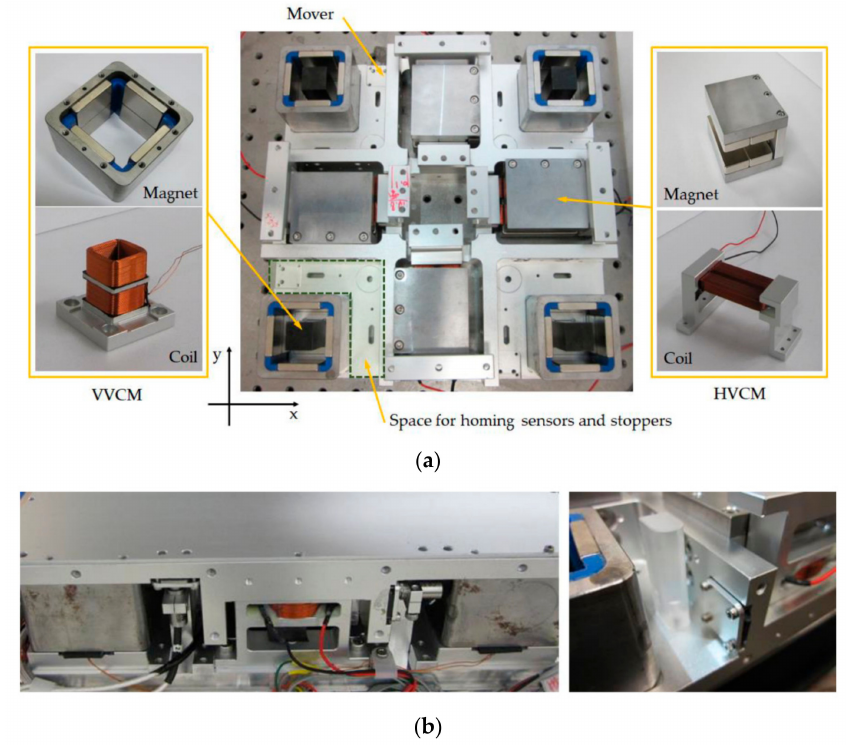
Figure 9. ( a ) Placement of the VCMs on the mover of the maglev device (inverted in the picture), ( b ) Placement of the displacement sensors and a mechanical stopper for homing.